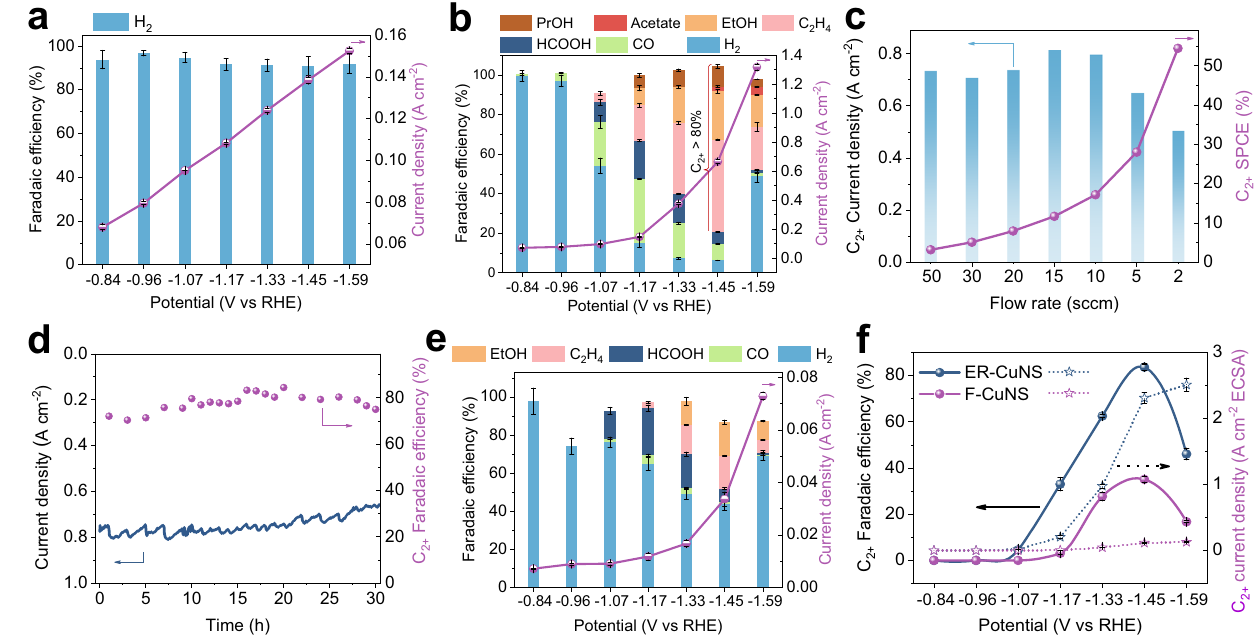
Fig. 2 | Electrocatalytic CO 2 RR performance inacidic electrolyte. a FE(left axis) and total current density (right axis) of ER-CuNS in 0.05M H 2 SO 4 at different applied voltages. b FE and total current density of ER-CuNS in 0.05M H 2 SO 4 with 3.0MKCladditives. c PartialcurrentdensityandSPCEofC 2+ productsonER-CuNS atdifferent CO 2 gas fl ow rate with anapplied voltage of − 1.50V RHE . d Totalcurrent density and C 2+ FE of acidic CO 2 RR during long-term stability test on ER-CuNS at